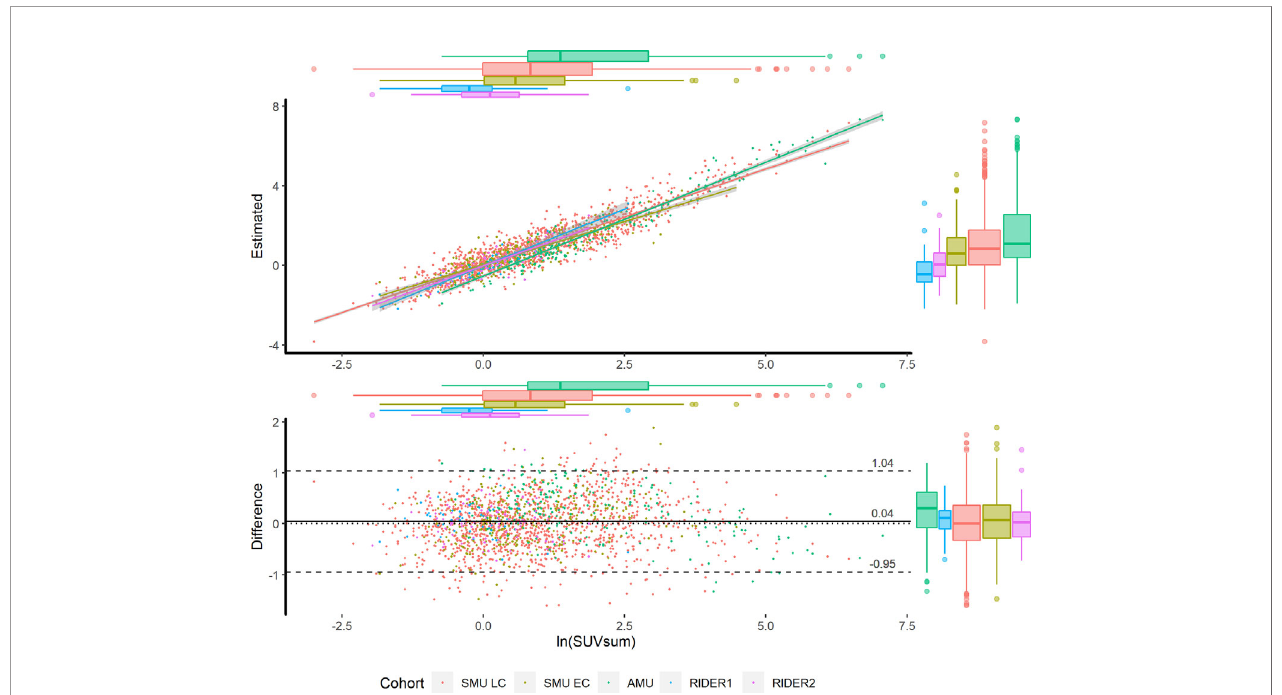
FIGURE 2 | Scatter plot (upper) and Bland-Altman plot (lower) in the training and validation cohorts. According to the cohorts, the scatters are grouped by colors. The x axes of the two plots are the measured ln(SUVsum). The y axes of the scatter plot and Bland-Altman plot present the estimated ln(SUVsum) and bias, respectively. The 95% CIs of regression lines between the measurements and estimations are in grey shadow, and the scatters distribution is illustrated by the box plots on the top and right